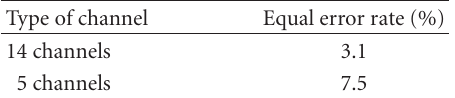
Table 3 . 1 . The comparative equal error rates.